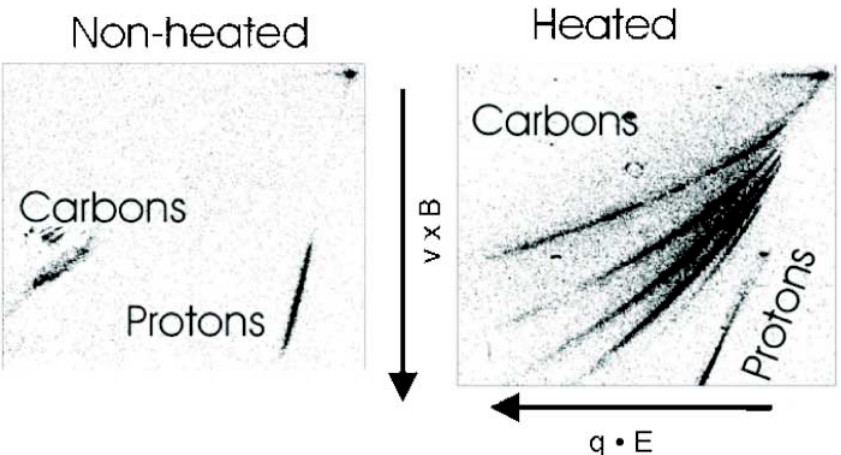
FIG. 5. Heavy ion beam production. In contrast to the strong proton signal (left), removing the hydrocarbons from the target rear surface results in a strong heavy ion (carbon) signal